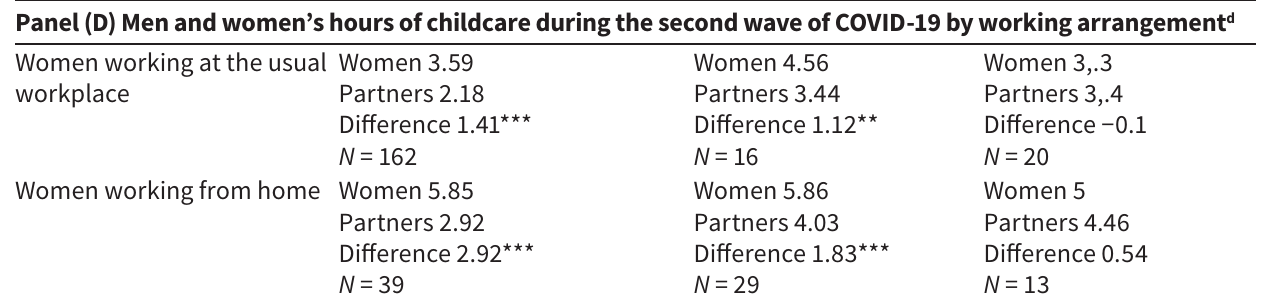
Panel (D) Men and women’s hours of childcare during the second wave of COVID-19 by working arrangement